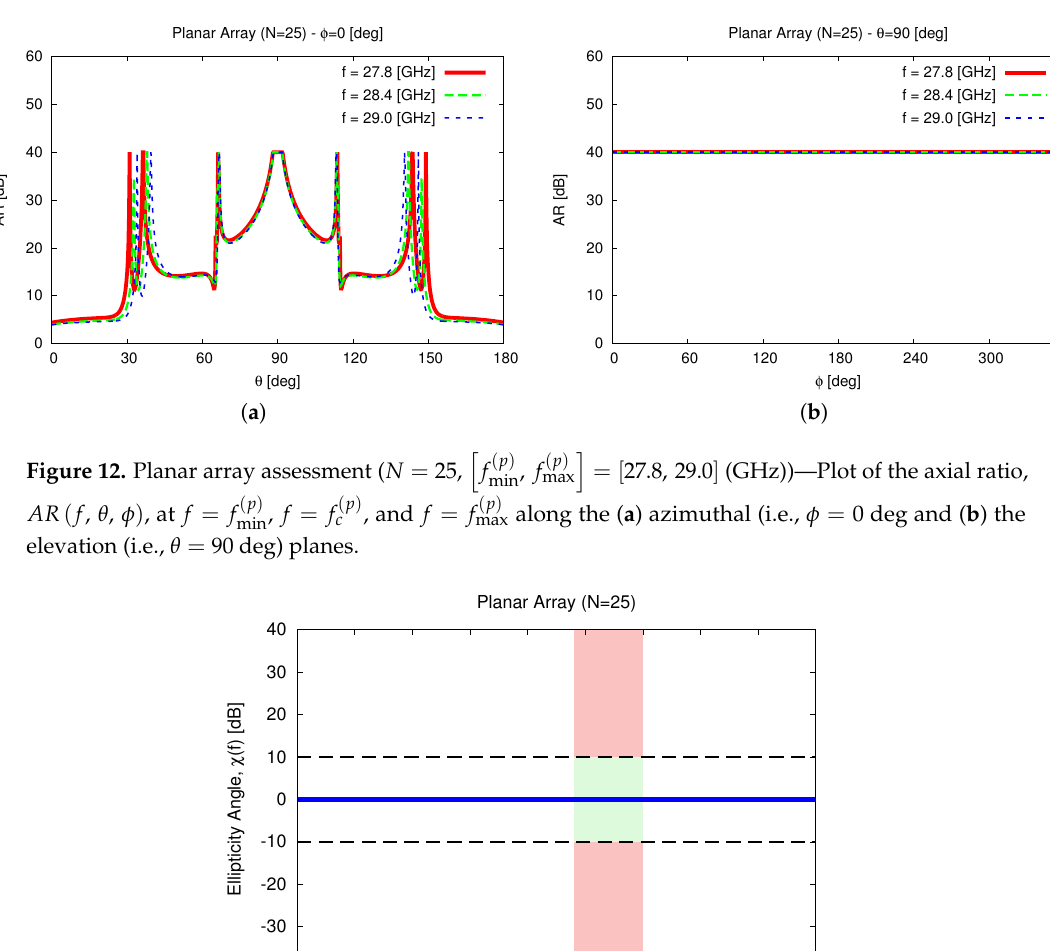
Figure 13. Planar array assessment ( N = 25, angle, χ ( f ) , versus the